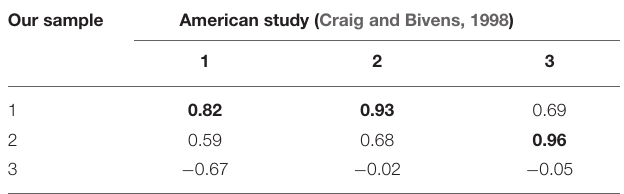
TABLE 6 | Coefficients of congruence ( 8 ) between factors of our sample and American study ( Haddy et al., 2005). Our sample American study (Haddy et al., 2005)